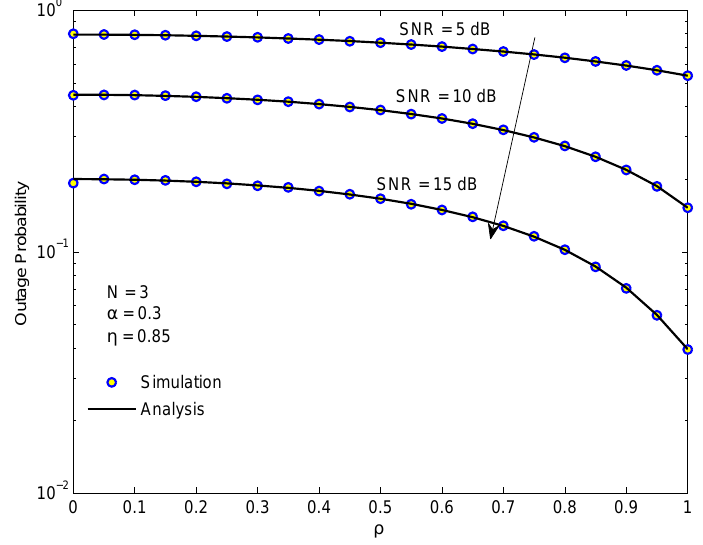
Figure 6. The outage probability of D 1 in the EH-NOMA relaying system versus the correlation coefficient for different average